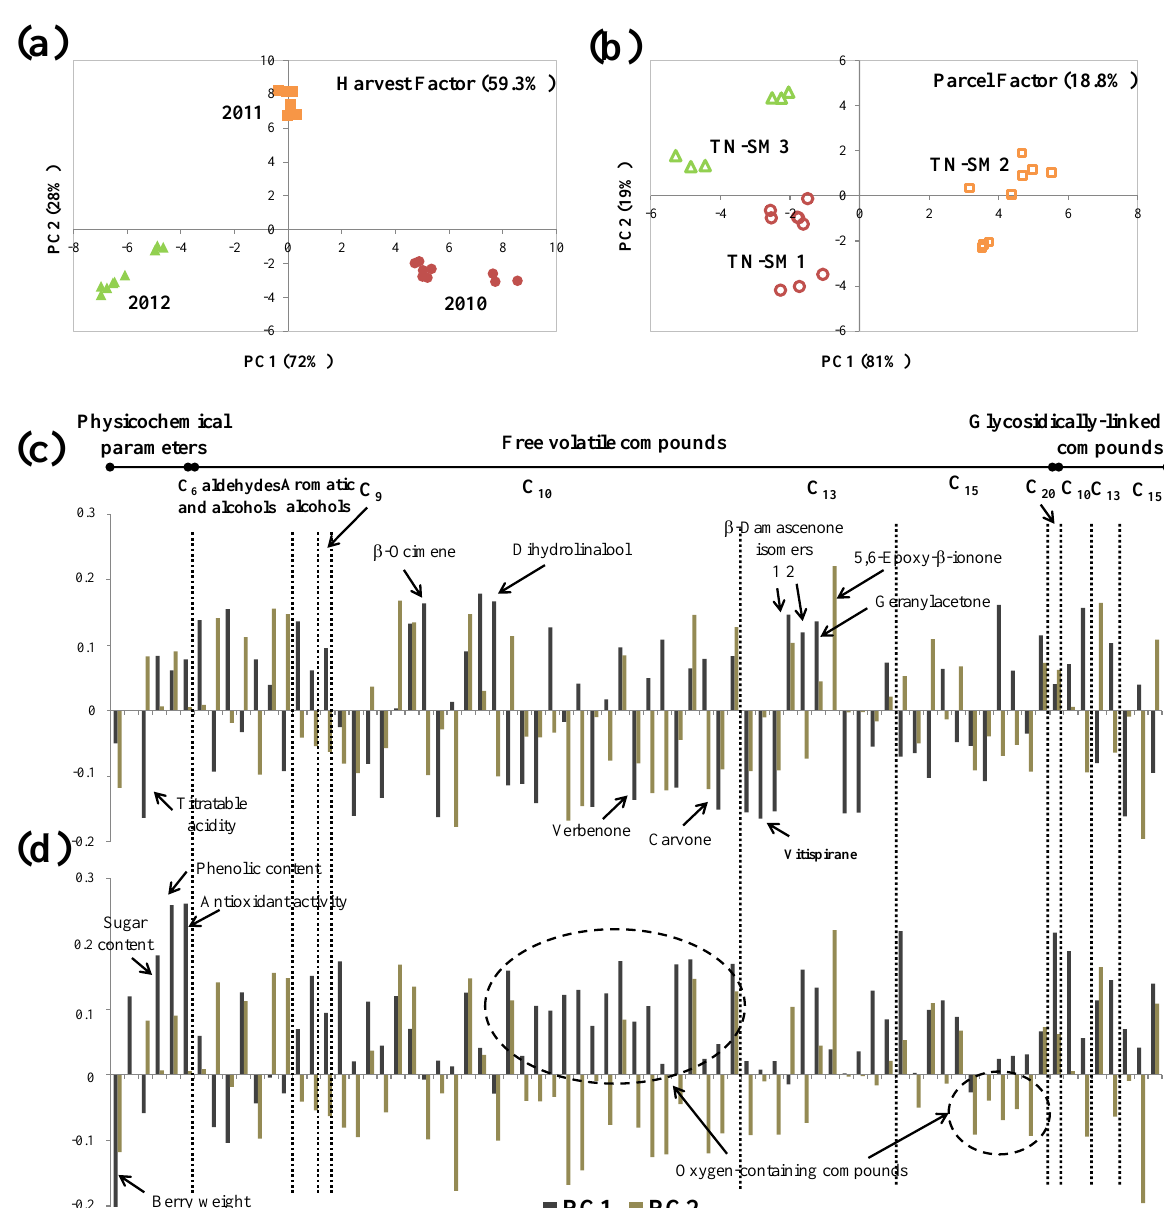
Figure 9. ASCA scores plot for ( a ) harvest and ( b ) parcel factors, and the corresponding variable loadings plot ( c , d ), respectively, obtained for Touriga Nacional, at technological maturity (significance test reported on Table 4). Each variable is normalized separately by dividing by its standard deviation value.